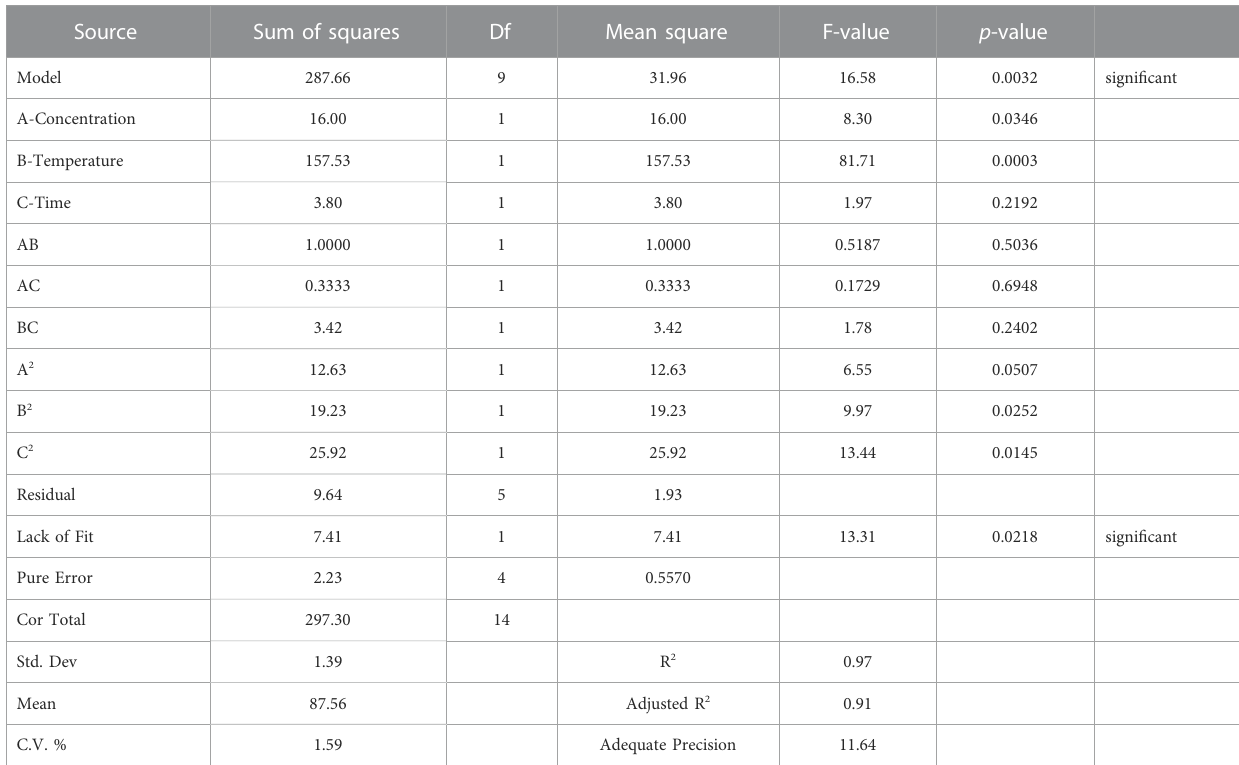
TABLE 4 ANOVA and fi t statistics for the quadratic regression